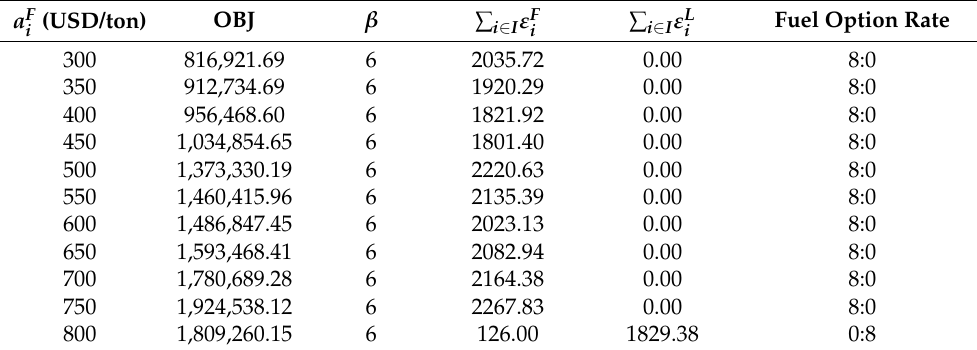
Table 3. Impact of the price difference between LSFO and LNG on the operation decisions. a F (USD/ton) i